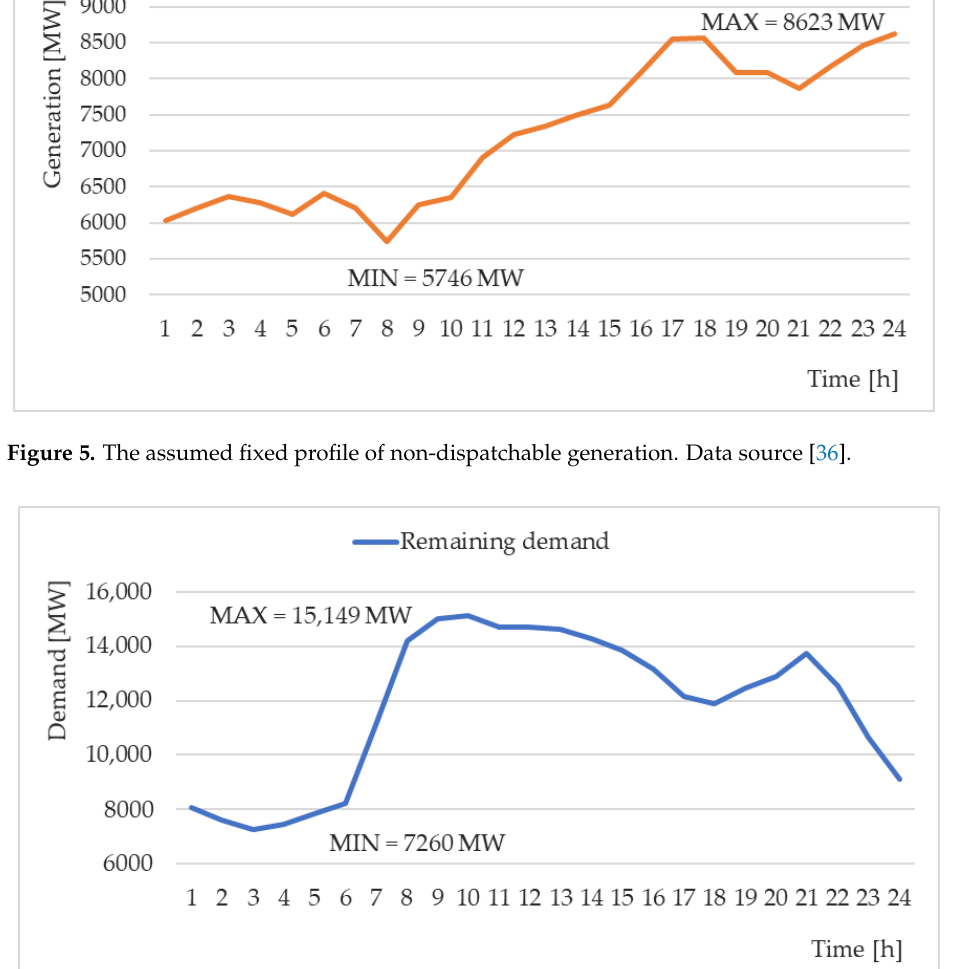
Figure 6. The remaining demand profile assumed for further simulations.